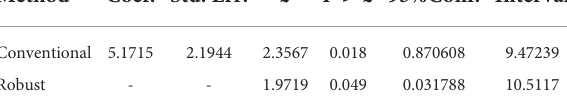
TABLE 7 RD analysis-linear fitting.